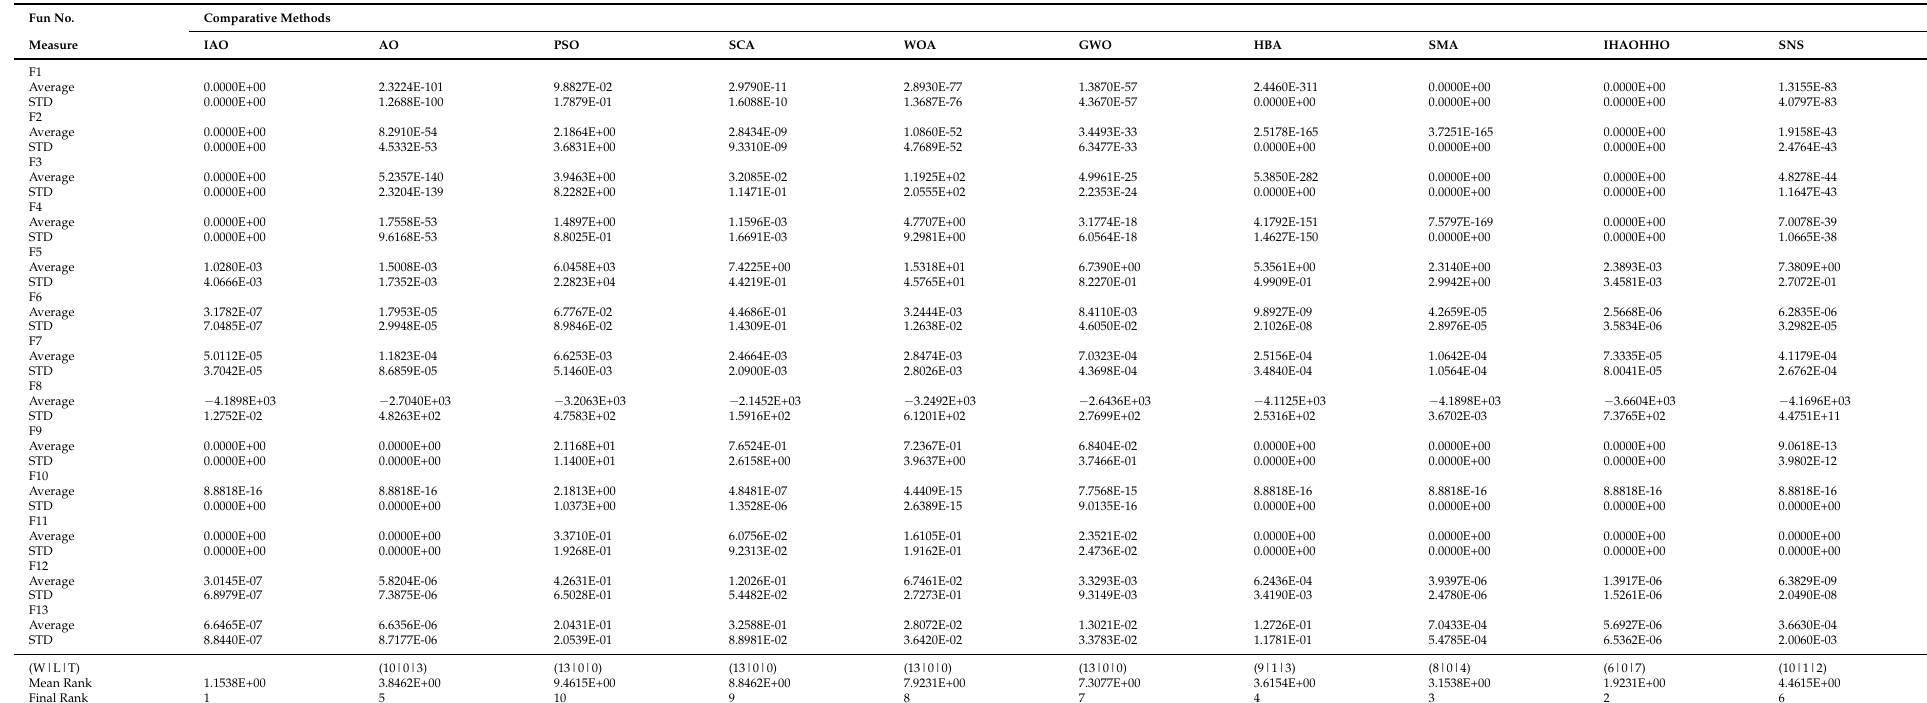
Table 5. Results of the comparative methods on classical test functions (F1–F13); the dimension is fixed to 10.